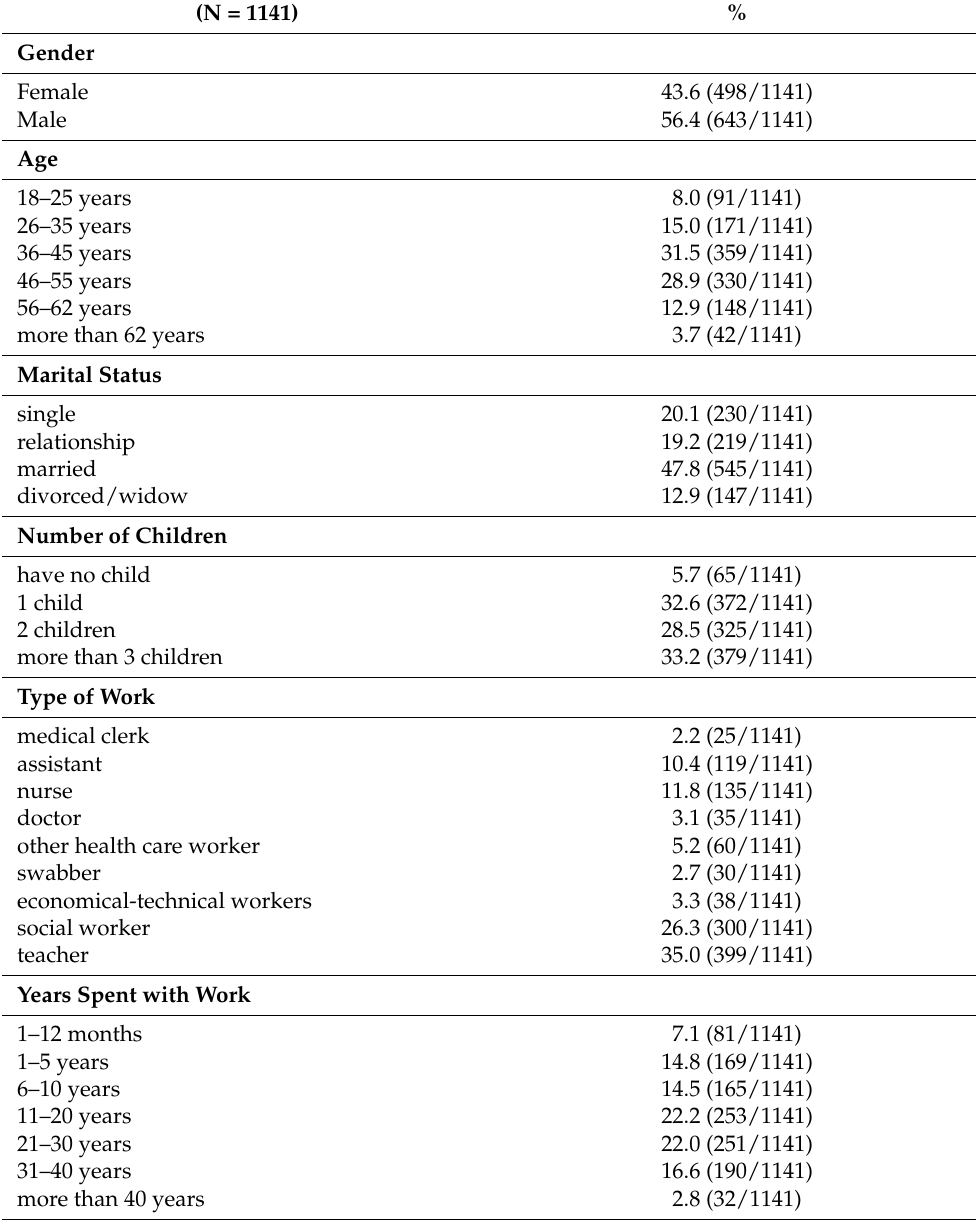
Table 1. Baseline characteristics of the study